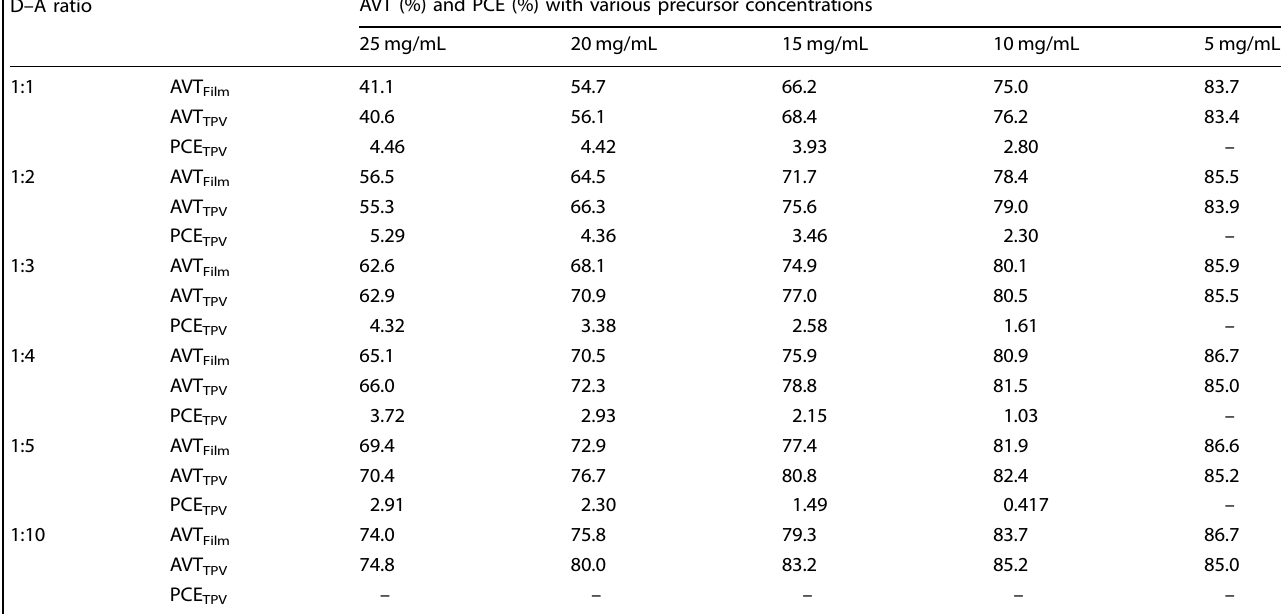
Table 1. Summarization of AVT and PCE in active layer fi lms and